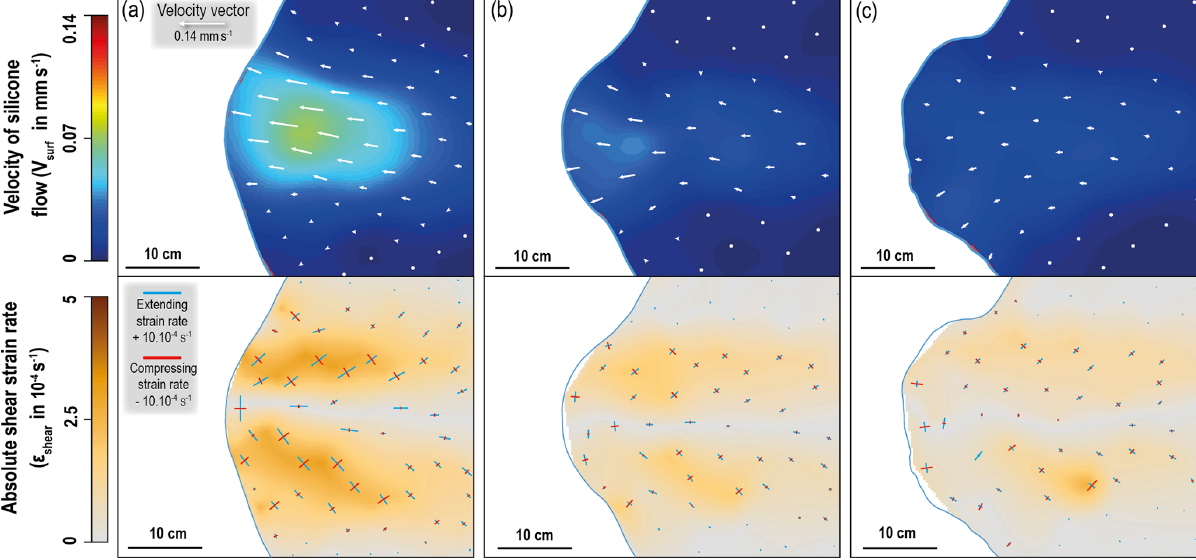
Figure 7. Temporal evolution (same stages a, b and c as in Fig. 6) of the silicone stream and lobe system, for a typical experiment with well-developed channelized drainage (Experiment 10). The upper and lower panels show (i) the velocity field of silicone flow (mms − 1 ) and the velocity vector maps of the silicone cap upper surface and (ii) extrapolated maps of absolute shear strain rate (s − 1 ) and the orientation of the principal axes of the instantaneous strain ellipse whose length corresponds to either the extending or the compressing strain rate ( ε in s − 1 ), respectively. Maps highlight the development of the fast-flowing corridor (i.e. silicone stream) surrounded by stagnant or very slow moving silicone (i.e. inter-stream area) and the formation of two symmetrical shear bands on both sides of the stream (i.e. the lateral shear